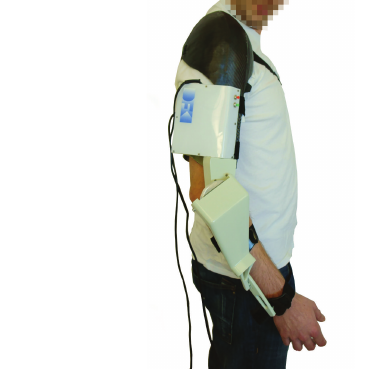
Figure 4: Design of the active orthosis.